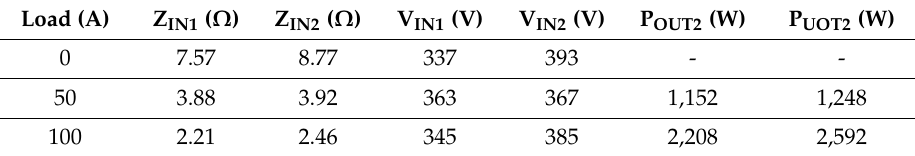
Table 1. Power imbalance characteristics of the auto-balancing converter.